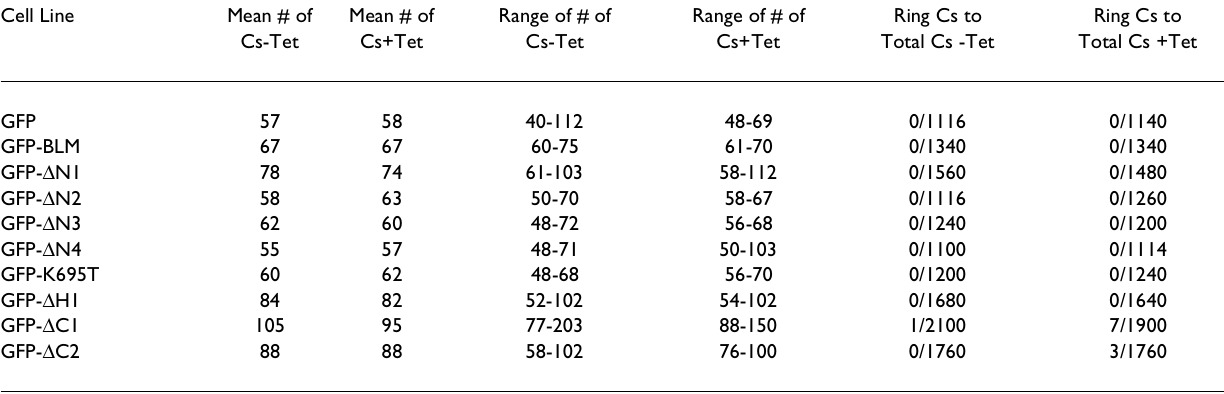
Table 3: Sister Chromatid Assay of Transfected Cell Lines: chromosome data Cell